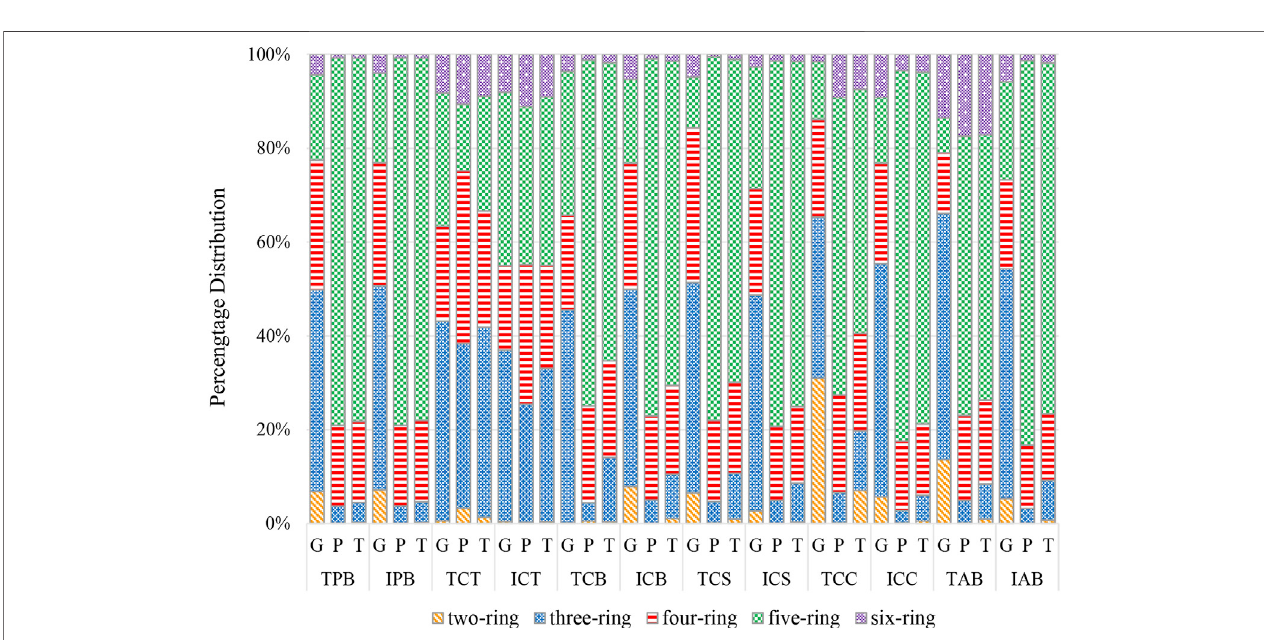
FIGURE 6 | Percentages of PAHs separated by the number of rings.